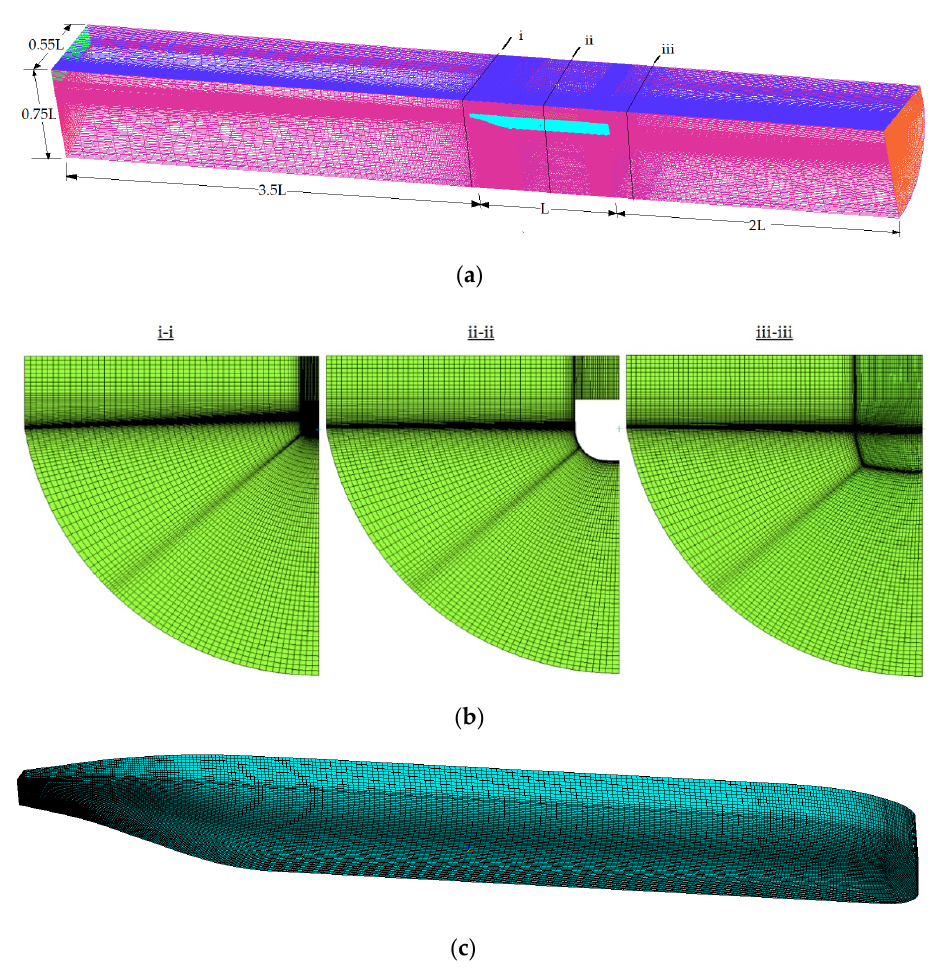
Figure 2. Simulated domain and structured mesh. ( a ) Mesh of simulated domain; ( b ) mesh at several cross sections in the simulated domain; ( c ) mesh in the hull surface of the model.